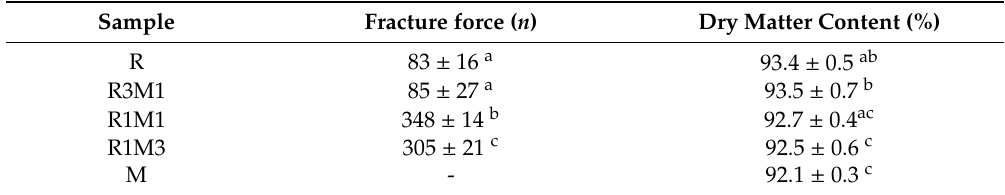
Table 6. Fracture force and dry matter content of printed 5-layer samples after baking and